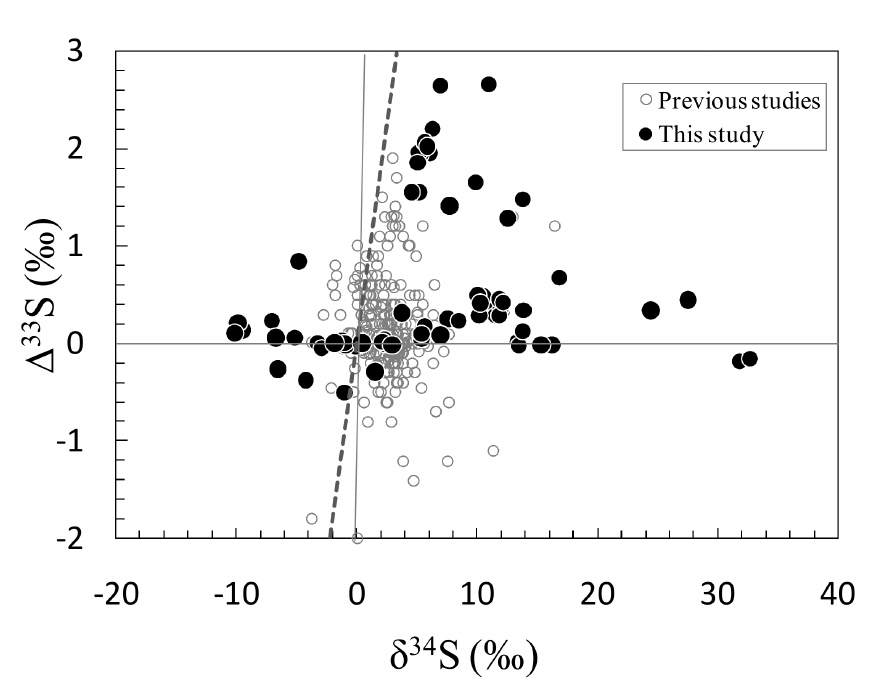
Figure 6. The Mesoarchean sedimentary sulfide δ 34 S and ∆ 33 S data. Grey unfilled circles are literature data for Mesoarchean samples from Southern Africa and Western Australia [23,26,31]. Filled black circles are data representing in this study in Table A1. Also shown is the dashed line represented the Archean reference array ( ∆ 33 S = 0.9 δ 34